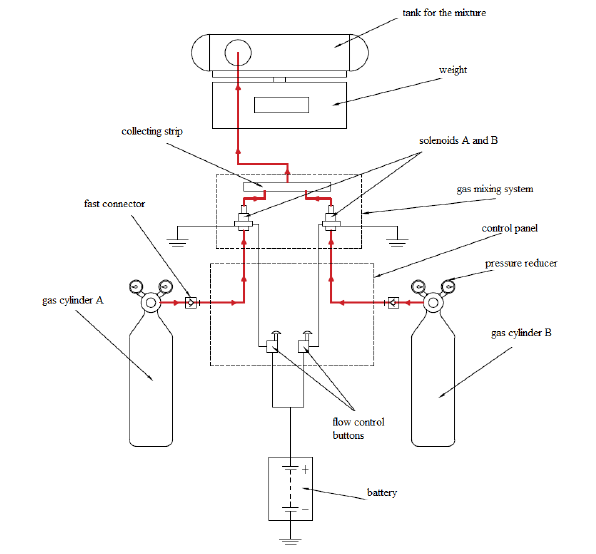
Fig. 1. Diagram of the station for the production of a gas mixture [6]